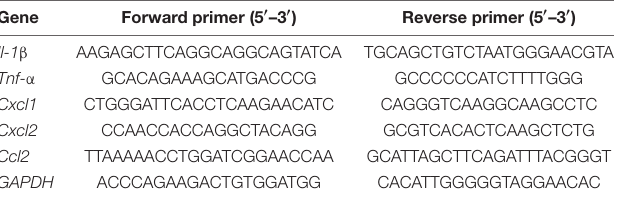
TABLE 1 | Primer sequences for